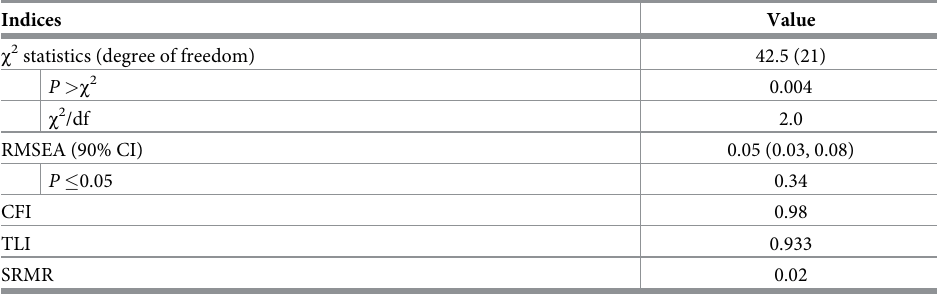
CFI: Comparative Fit Index; RMSEA: Root Mean Square Error of Approximation; TLI: Tucker Lewis Index; SRMR: Standardized Root Mean squared Residual.